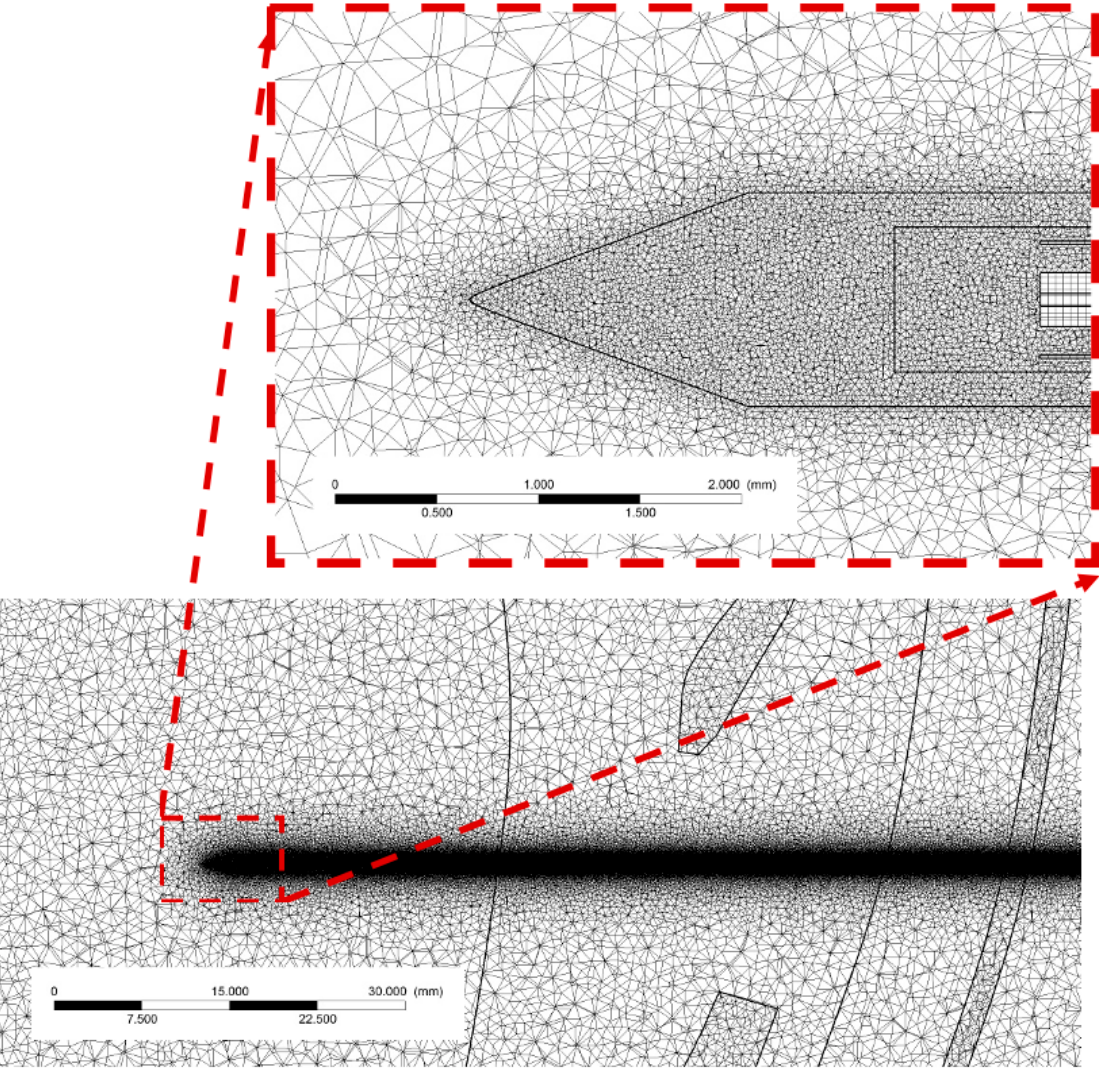
Figure 3. Representative image of the mesh near the microwave probe used in the CFD simulations. The images correspond to the coarsest mesh investigated; 4.3 million nodes and 18.7 million ele- ments.